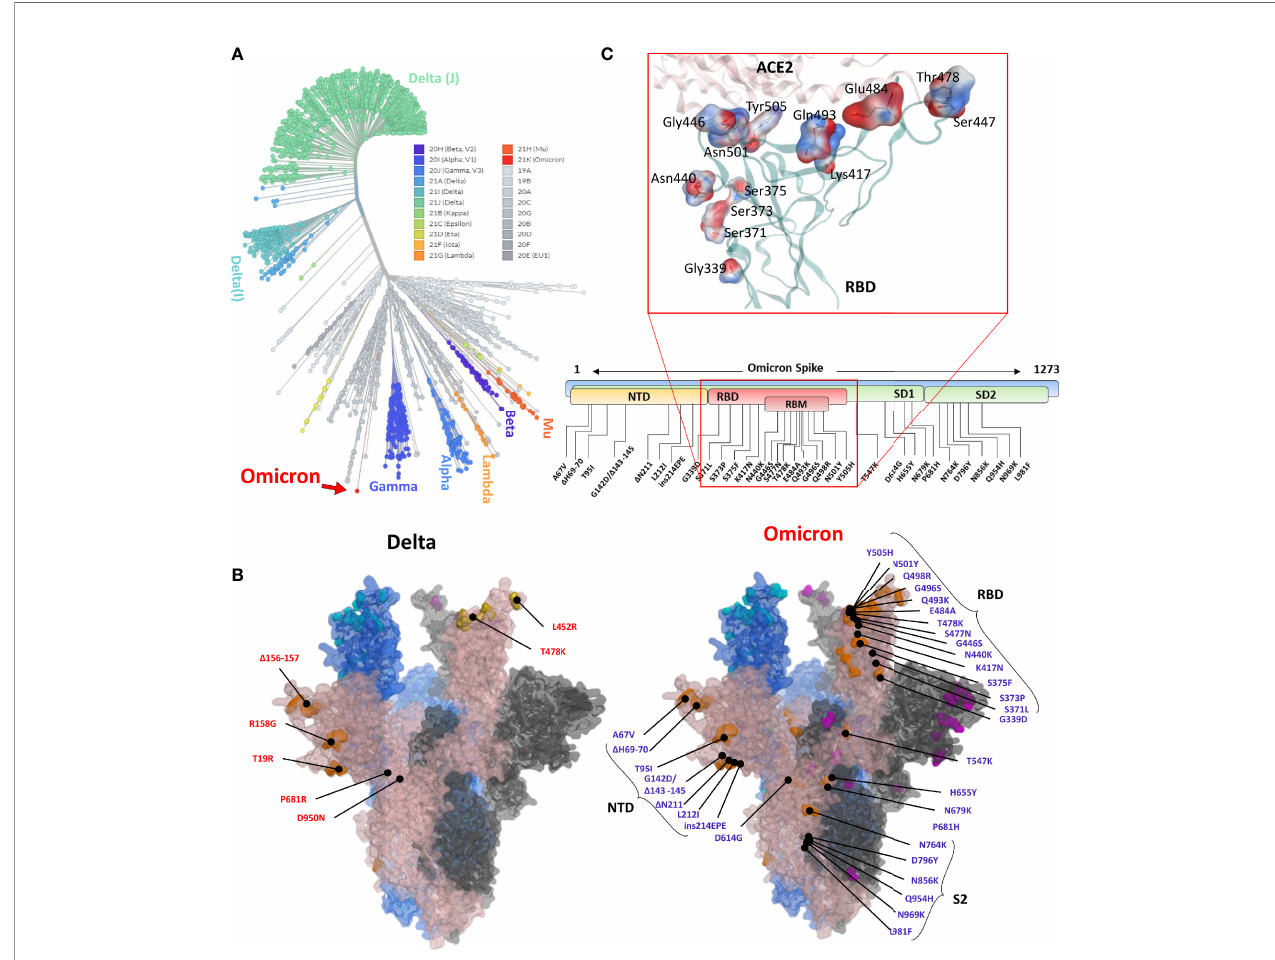
FIGURE 1 | (A) Phylogeny of the Omicron and annotation of the mutation in Spike protein. The unrooted phylogenetic tree was constructed from the Nextstrain servers. Wuhan-Hu-1/2019 strains were taken as a reference sequence. (B) The full-length Delta and Omicron Spikes were built to annotate the relative (not exact) positions of the mutations on the surface map of Spike. (C) The amino acids mutated in the RBD of Omicron are shown concerning the ACE2 interface. Residues are colored according to the electrostatic map of the WT strain. The respective Omicron mutations are depicted in the panel below the RBD surface